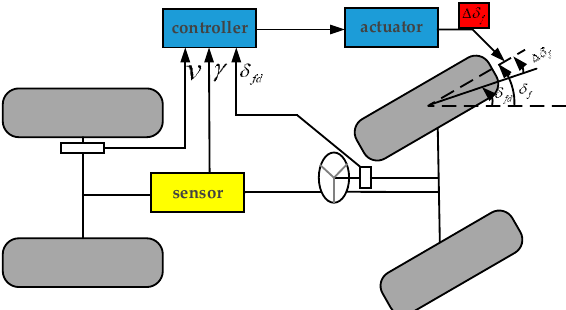
Figure 5. Mechanical superposition active steering schematic diagram.